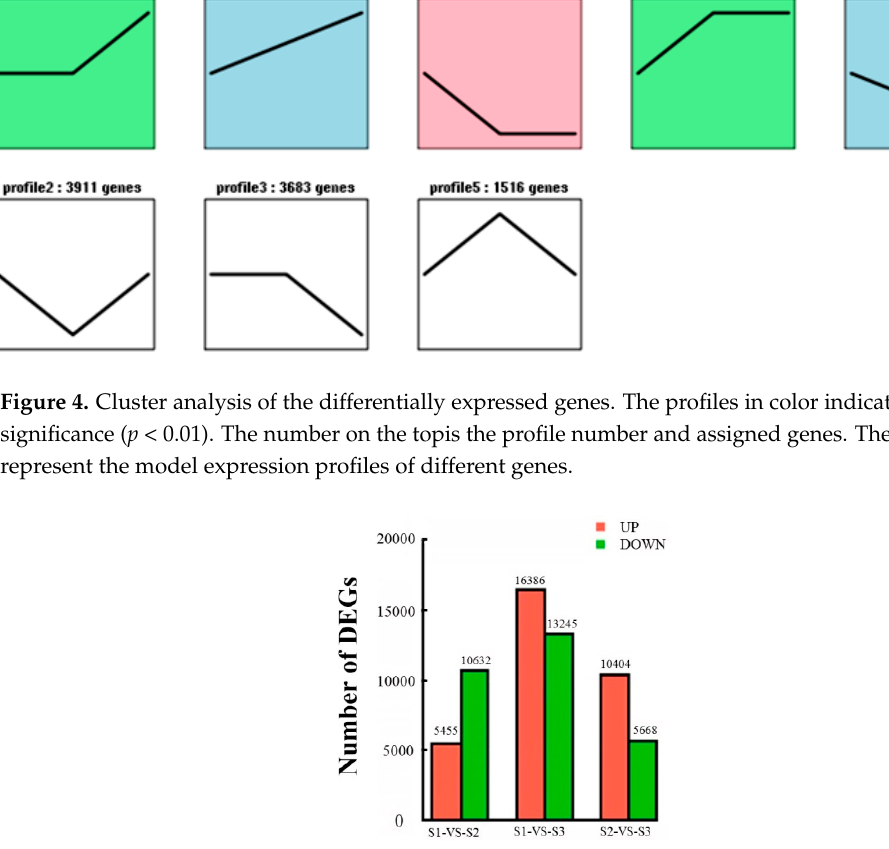
Table 3. The KEGG enrichment of DEGs among the three flowering